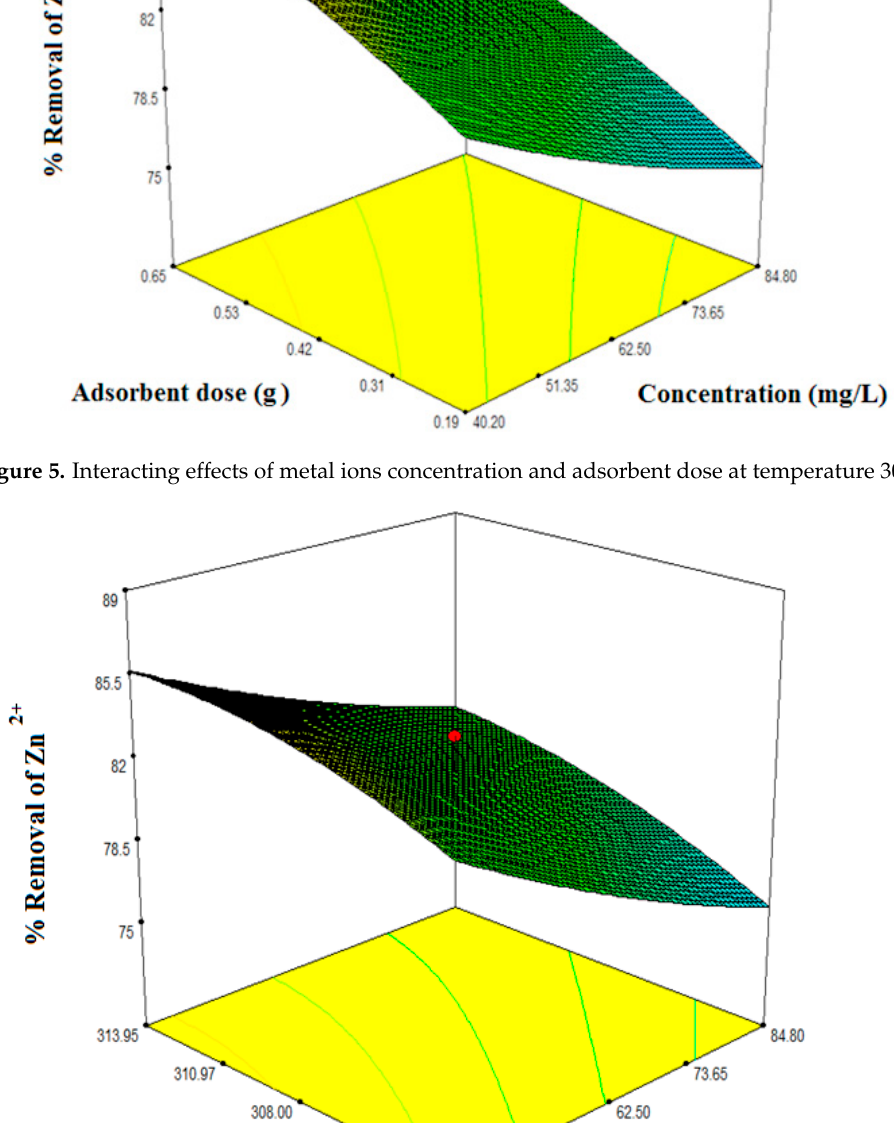
Figure 6. Interacting effects of metal ions concentration and temperature at an adsorbent dose 0.42 g.